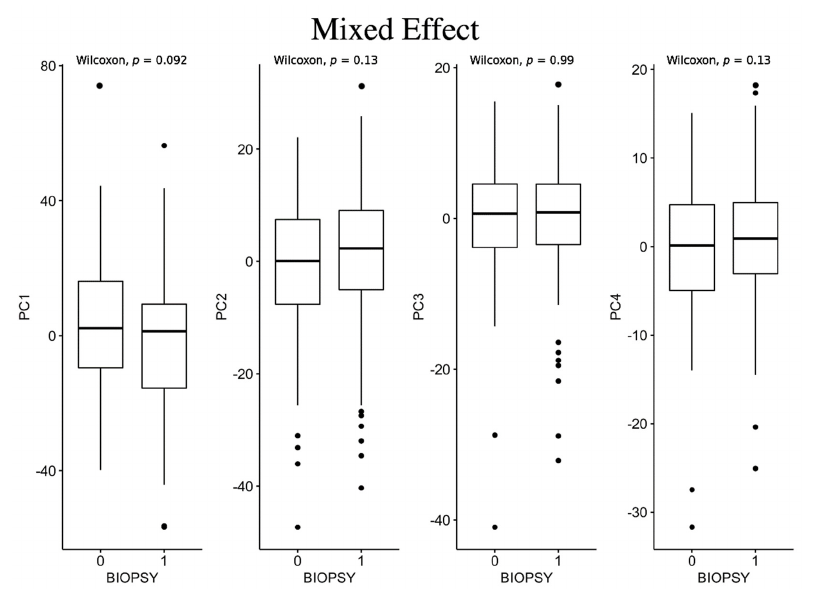
Figure 6. Box plots for mixed effect method between negative biopsy (class 0) and positive biopsy (class 1).